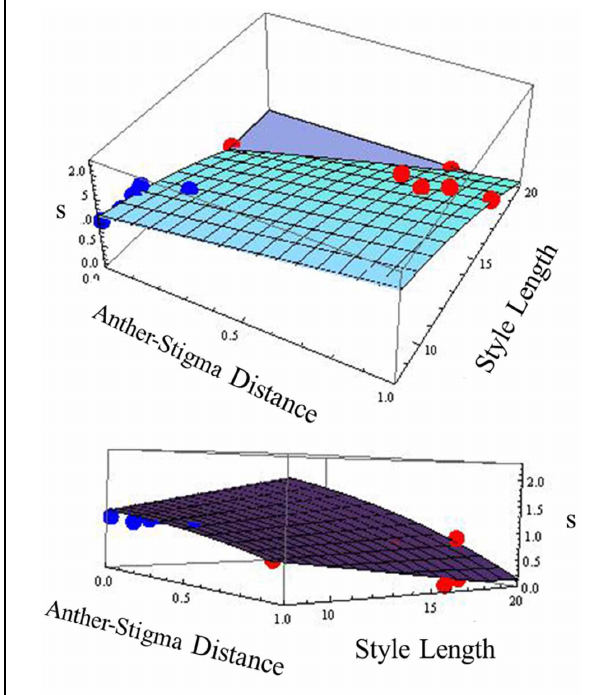
FIGURE 2 | Relationship across populations between selfing rate (s) and anther-stigma distance and style length. The best-fit surface is specified by s = 1 . 482 + 0 . 818 asd − 0.0054 style length 2 [ R 2 = 0 . 79, F ( 2 , 9 ) = 16 . 58, p < 0 . 001]; Significance of asd: F ( 1 , 9 ) = 11 . 63, p = 0 . 0077. Significance of style length 2 : F ( 1 , 9 ) = 31 . 36, p = 0 . 0003. Red points: I. cordatotriloba. Blue points: I. lacunosa . The two figures are different views of the same relationship.